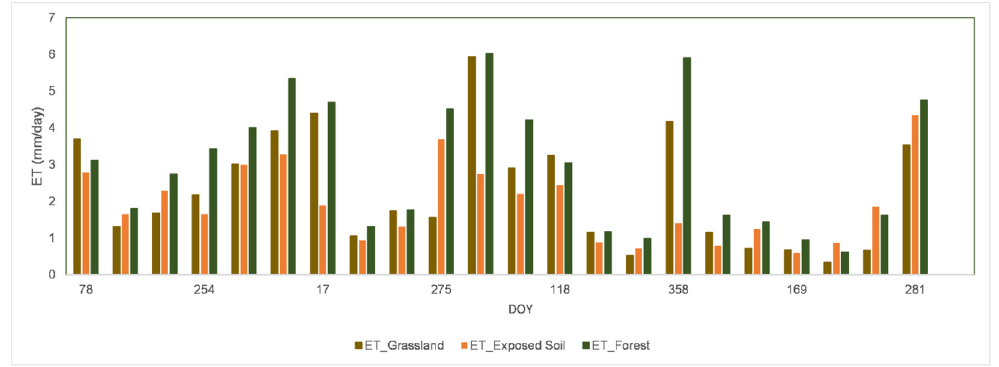
Figure 4. Daily evapotranspiration (mm/day) for different land surface uses in Pampa biome.